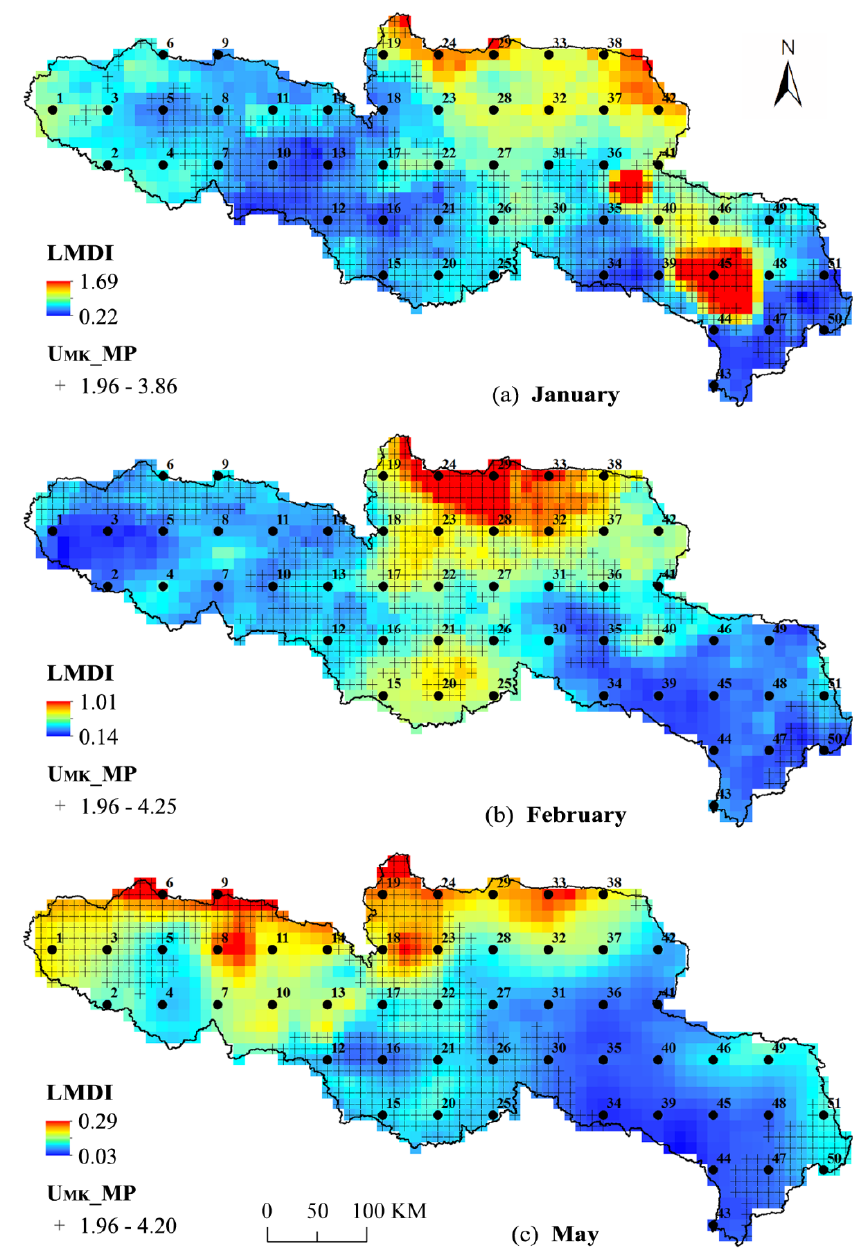
Figure 6. The spatial distribution of the LMDI (long-term marginal disorder index) and the